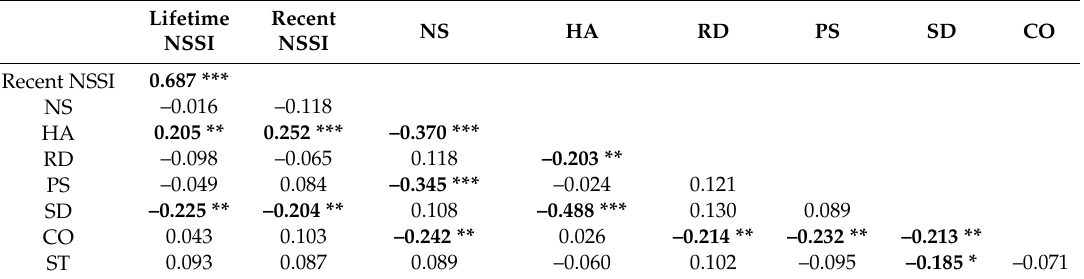
Table 3. Correlation coe ffi cients between study